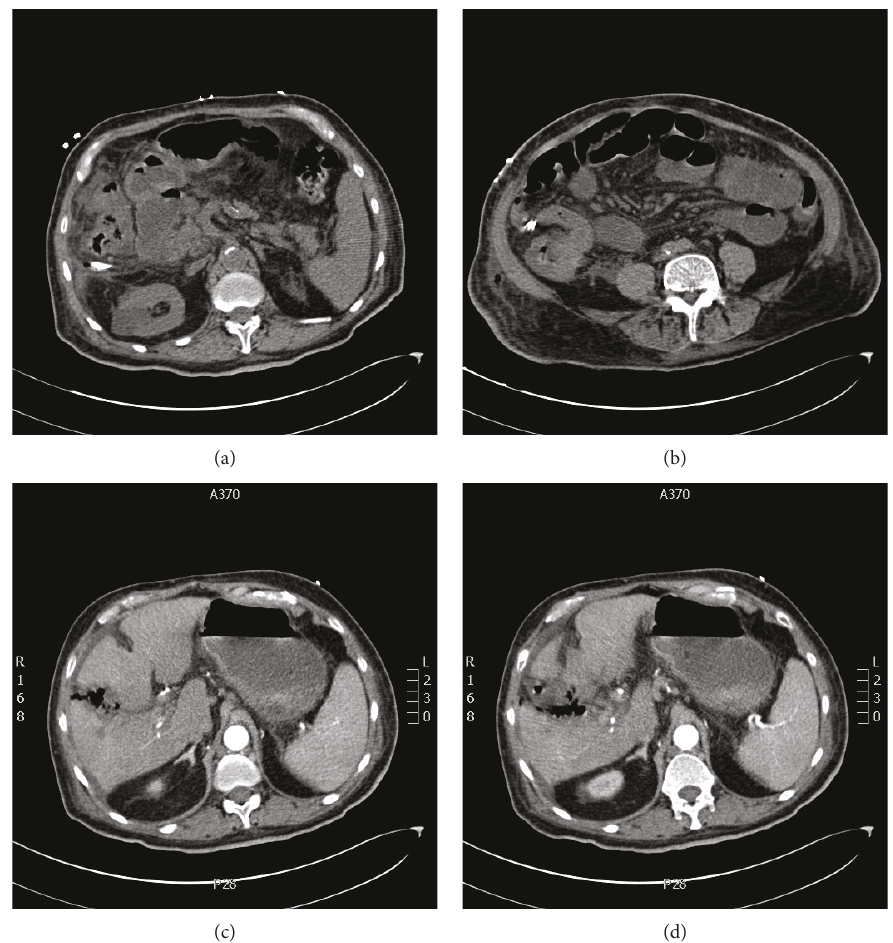
Figure 1: (a, b) CT Abdomen showing cecal mass. (c, d) CT abdomen showing post cholecystectomy